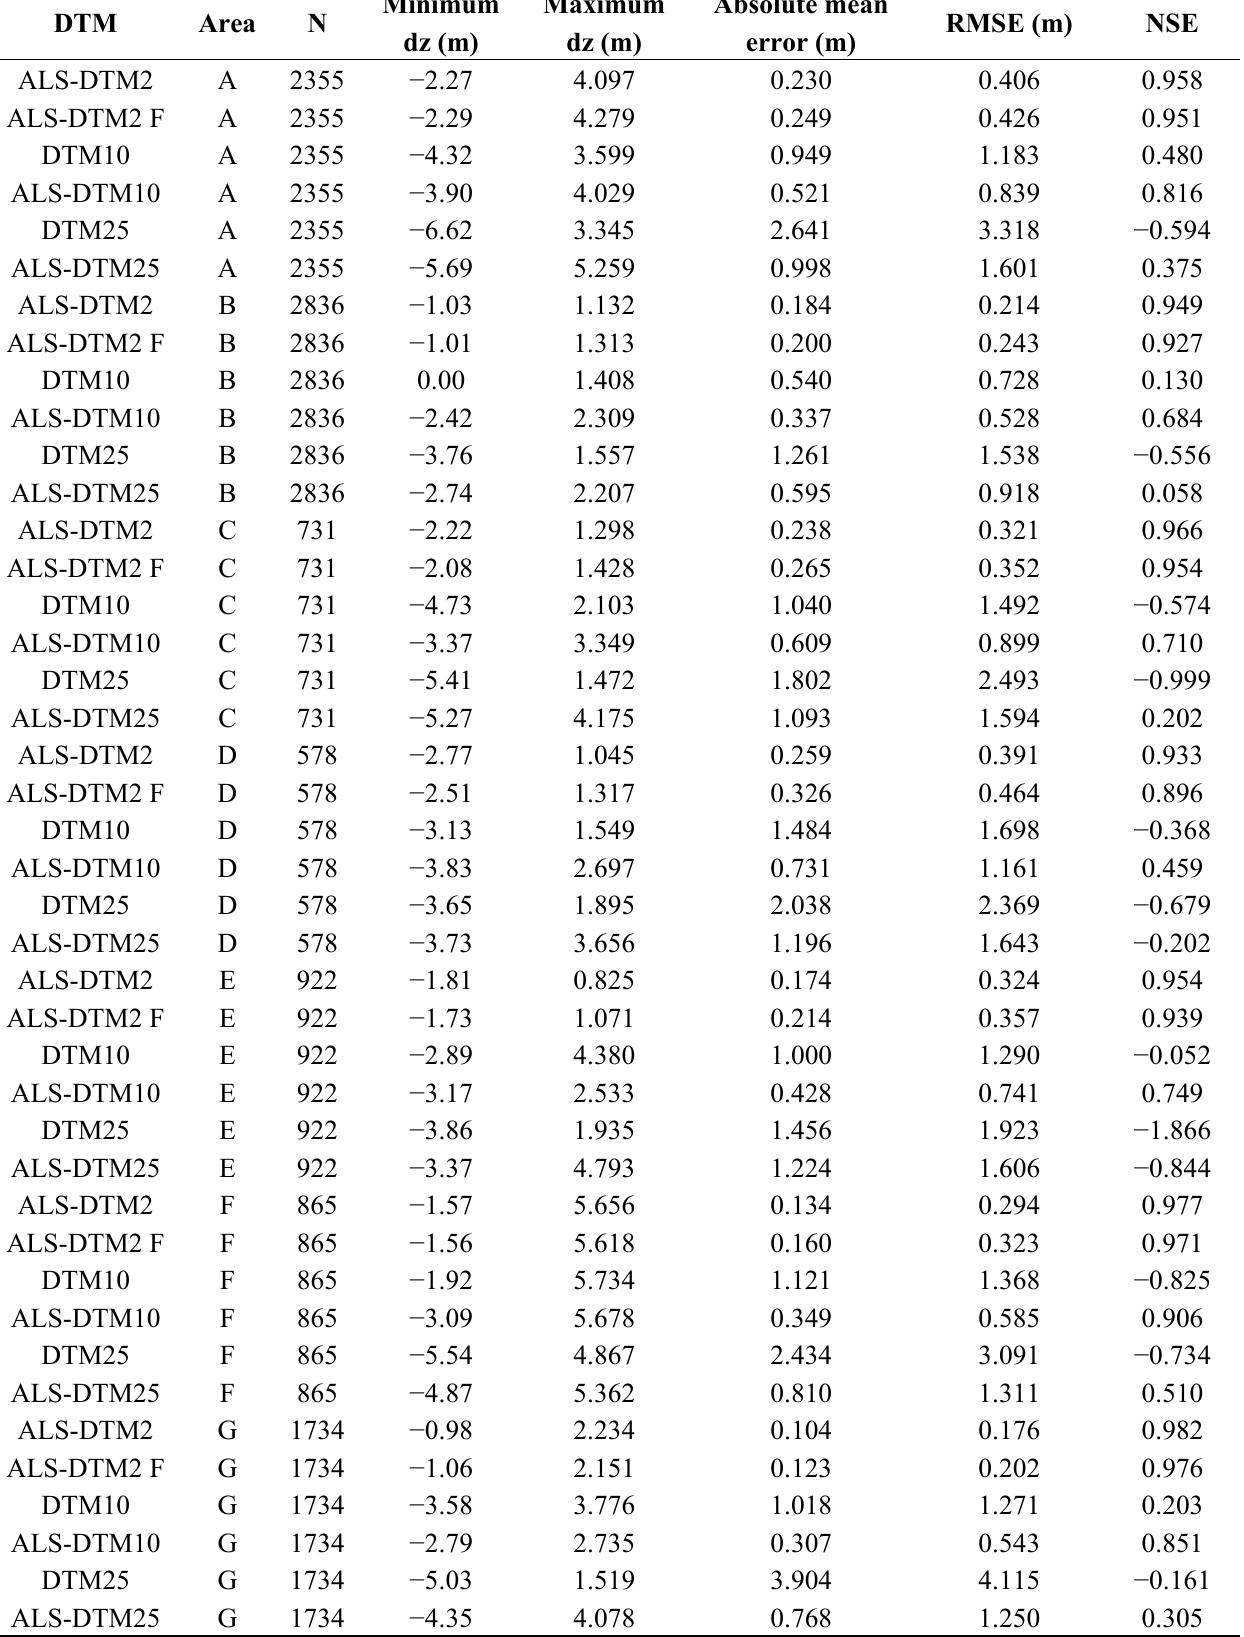
Table 2. Difference between reference data and DTMs. N is the number of reference points in the reference